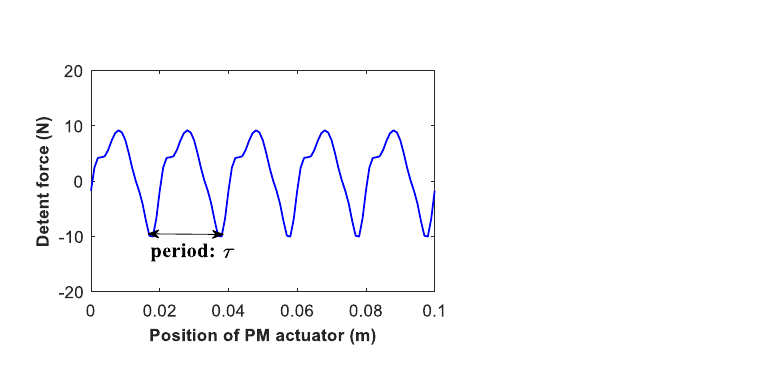
Figure 6. Detent force of segmented PMLSM.